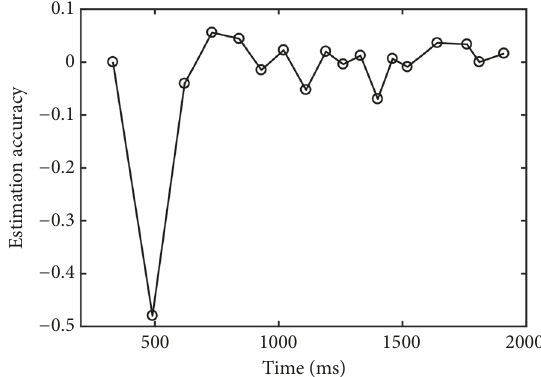
Figure 8: Estimation accuracy during AMT startup under the first gear.